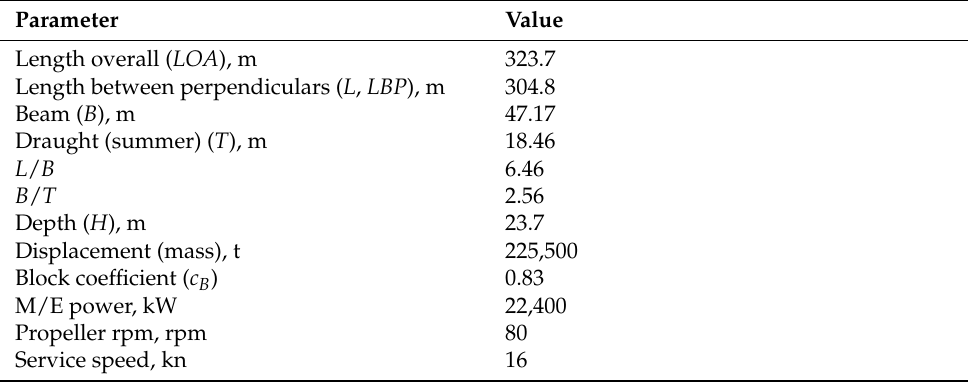
Table 1. Ship data (ESSO 193 kDWT